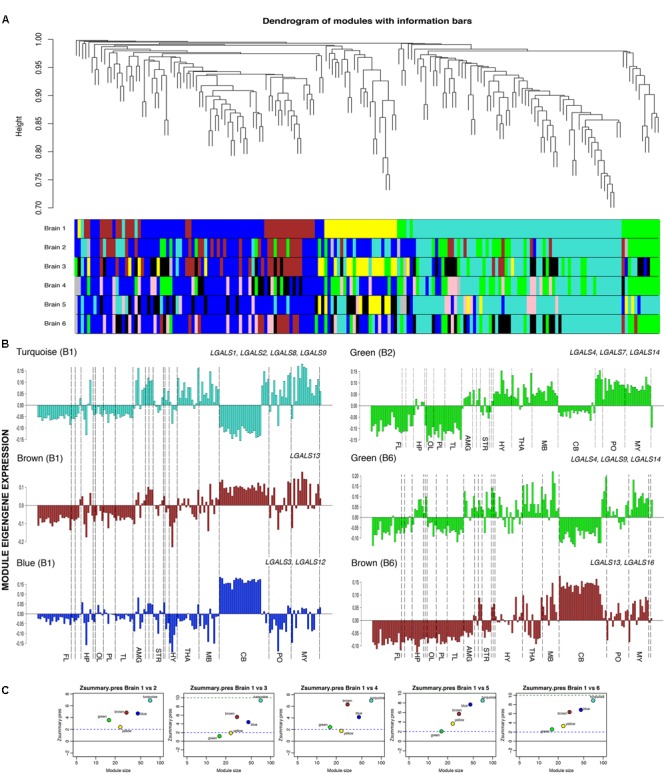
Weighted co-expression networks and modules. (A) Top: Dendrogram from gene co-expression network analysis of galectins and their regulators. Bottom: Modules of co-expressed genes were assigned a color and all modules from each human brain are shown. (B) Module eigengene expressions for different modules in different brains are shown, FL, frontal lobe; HP, hippocampus; OL, occipital lobe; PL, parietal lobe; AMG, amygdala; STR, striatum; HY, hypothalamus; THA, thalamus; MB, midbrain; CB, cerebellum; PO, pons; MY, medulla. Selected galectins in each module are shown. (C) Preservation measure Zsummary between brain 1(B1) vs. the other 5 donor brains.